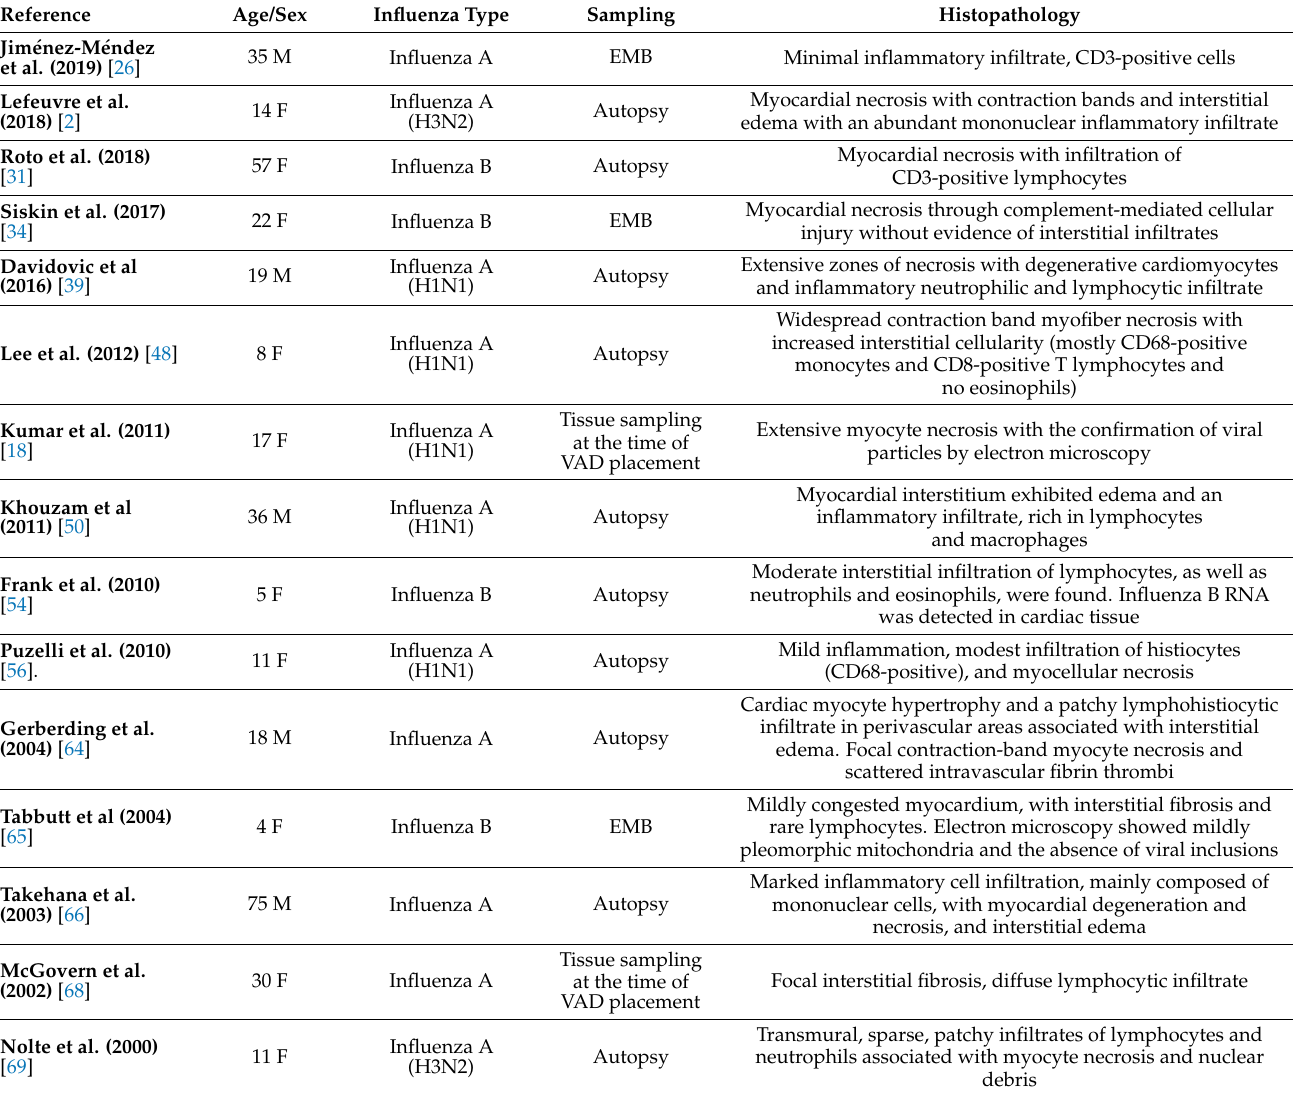
Table 3. Histopathologic findings of myocardial